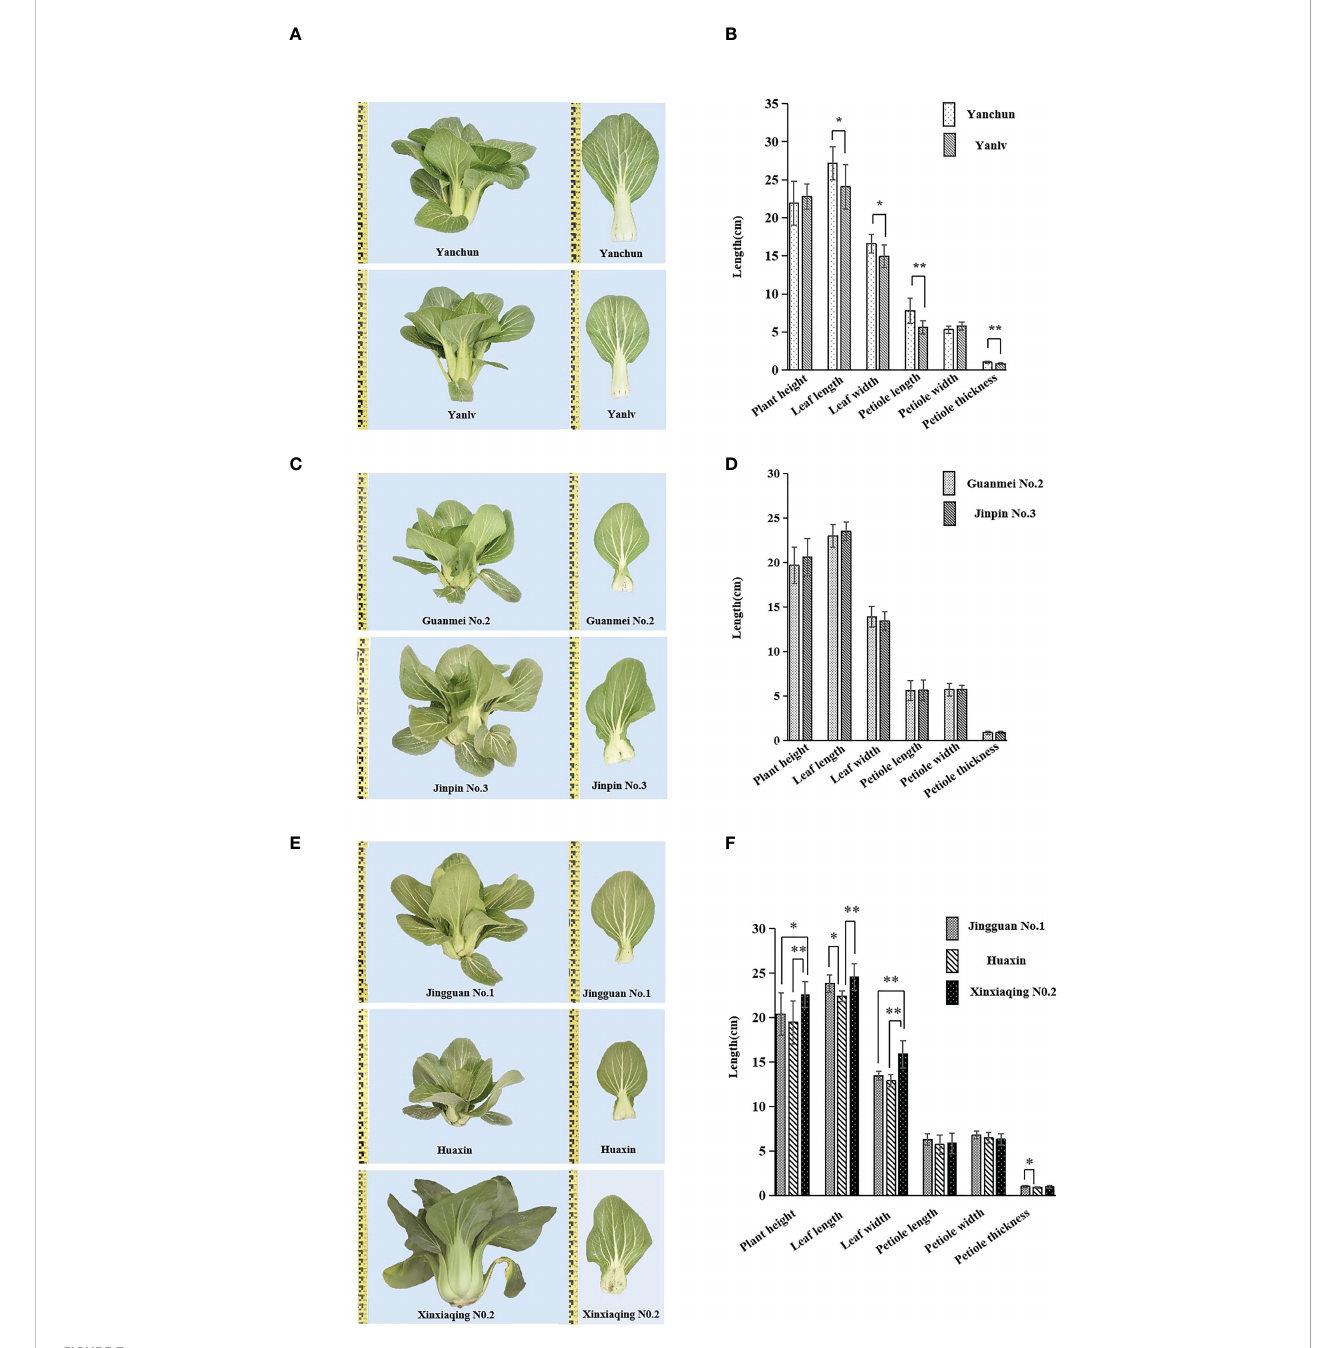
FIGURE 7 Phenotype comparison and quantitative characteristics ANOVA of fi ve groups of varieties with no differences in simple sequence repeat (SSR) markers: ‘ Yanchun ’ and ‘ Yanlv ’ (A, B) ; ‘ Guanmei No. 2 ’ and ‘ Jinpin No. 3 ’ (C, D) ; ‘ Jingguan No. 1 ’ and ‘ Huaxin ’ , ‘ Jingguan No. 1 ’ and ‘ Xinxiaqing No. 2 ’ , and ‘ Huaxin ’ and ‘ Xinxiaqing No. 2 ’ (E, F) . Ten plants were used for the analysis (*signi fi cant at p < 0.05; **highly signi fi cant at p <